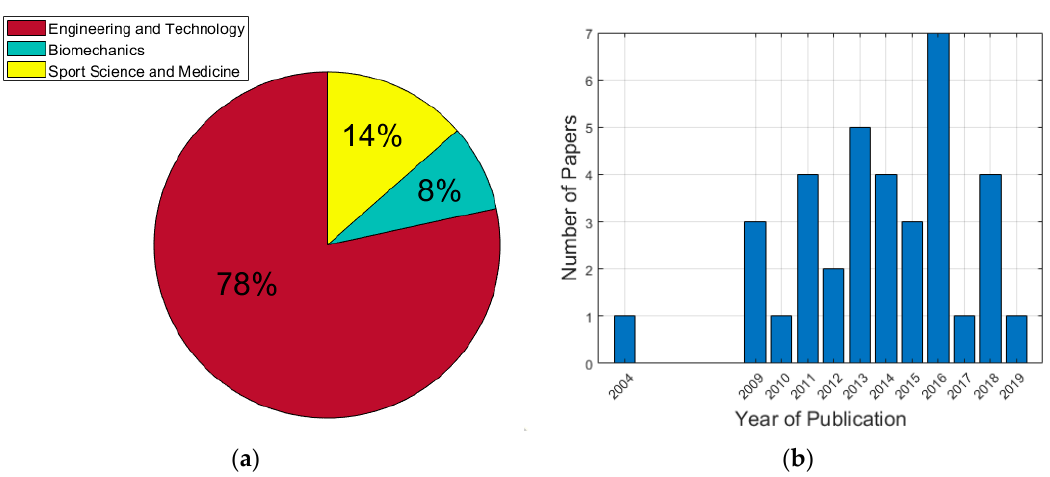
Figure 2. ( a ) journal distribution; ( b ) publication frequency by year. The total number of papers since 2004 is 35.